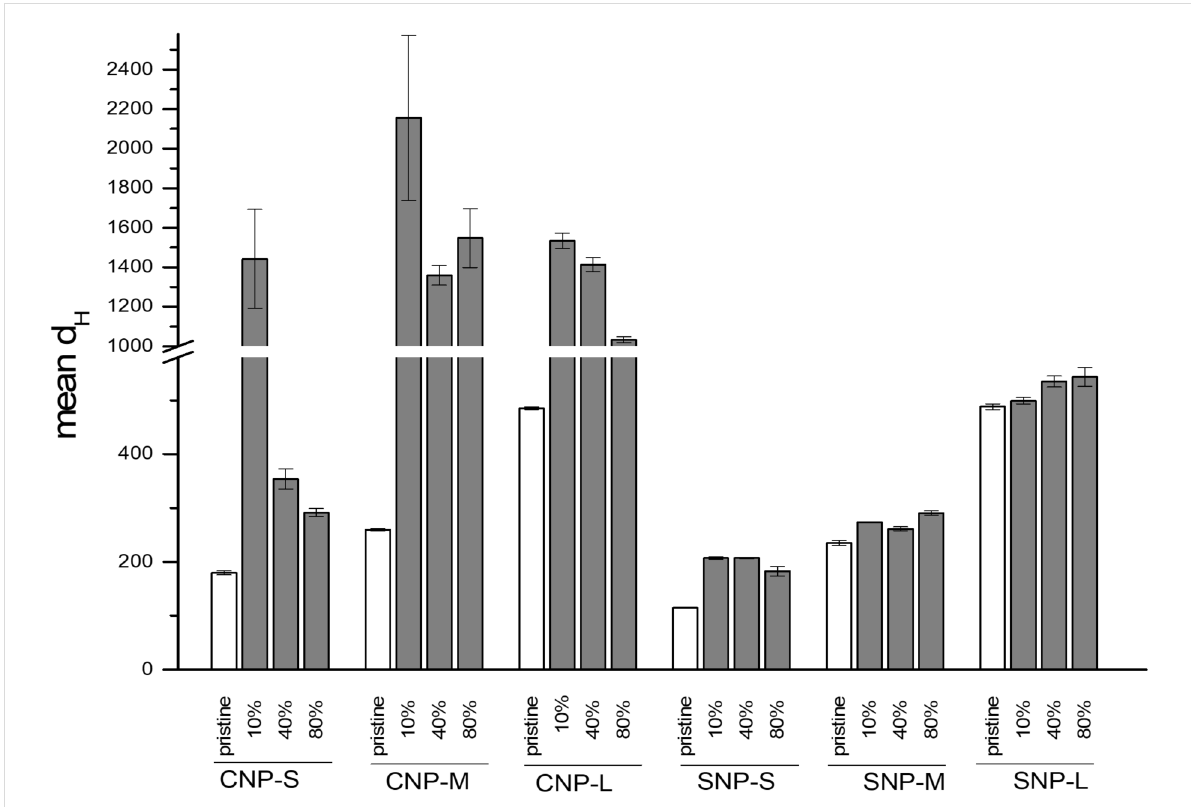
Figure 8: Effect of hard corona formed at different plasma concentrations on nanoparticles agglomeration in